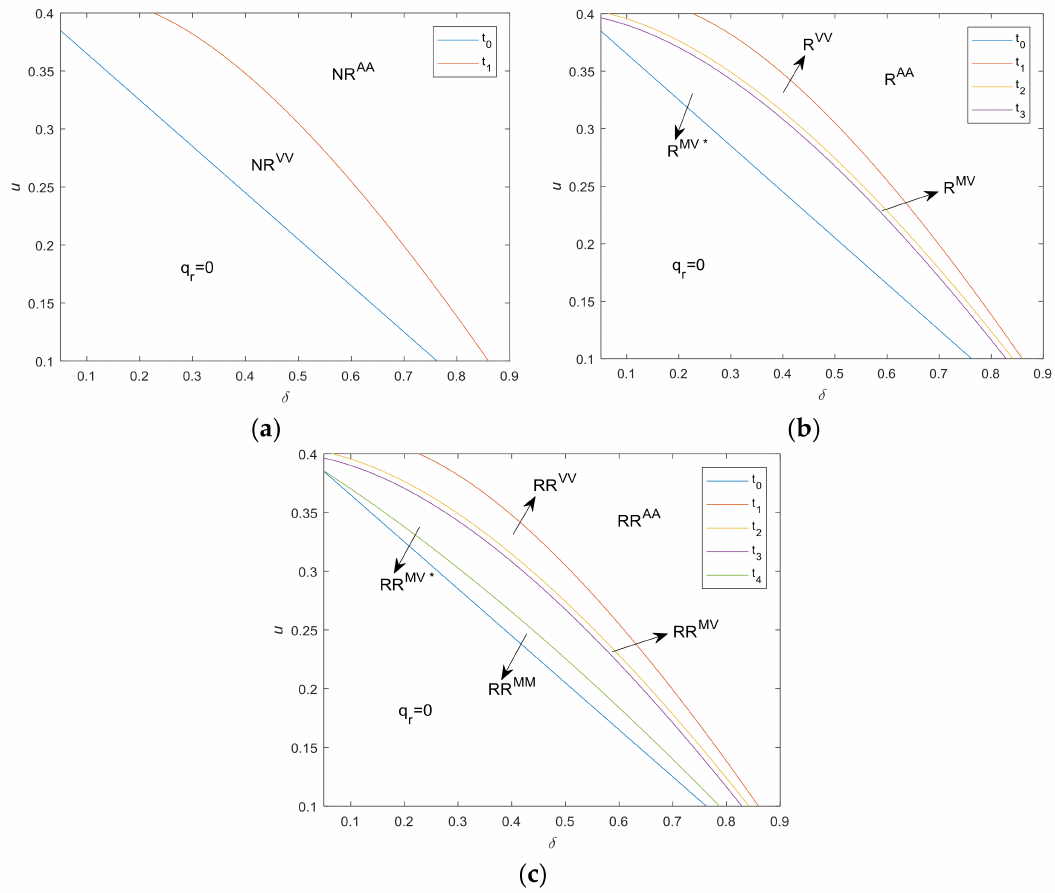
Figure 2. Optimal strategies in absence of cap-and-trade regulation. ( a ) no take-back regulation; ( b ) under take-back regulation with collection target; ( c ) under take-back regulation with both collection and remanufacturing targets. (Note, c n = 0.4, c c = 0.05, α = 0.5, τ c = 0.6, τ r =